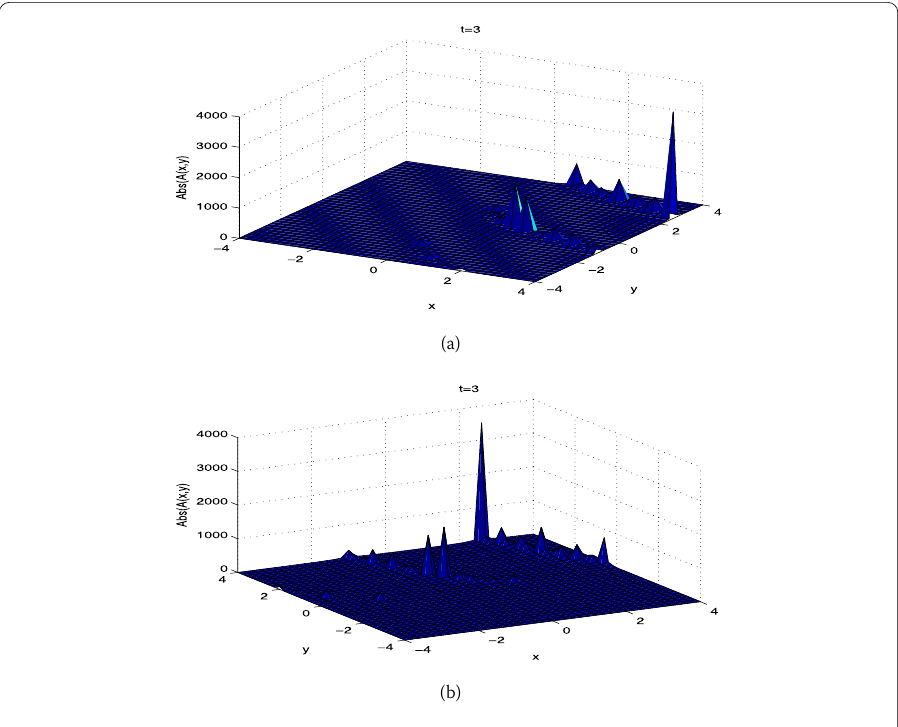
Figure 5 ( a ) The exact solution represented by Eq. (78), t = 3, α = 1, β = 0.5, γ = 1. ( b ) The exact solution represented by Eq. (78), t = 3, α = 1, β = 1, γ = 0.5